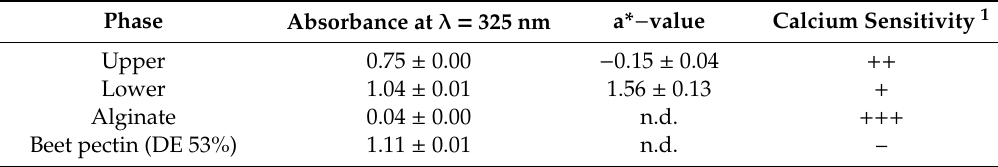
Table 1. Characterization of the upper and lower biopolymer phase of a mixed beet pectin–alginate